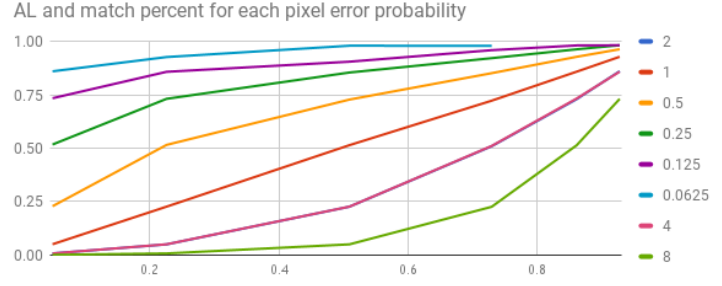
Figure 5. Accuracy level and distribution effect on right matching probability. The lines represent different AL values in logarithmic scale. The y -axis represents the probabilistic error we added to each distance. The x -axis represents the probability to retrieve star triplets from the BSC with that